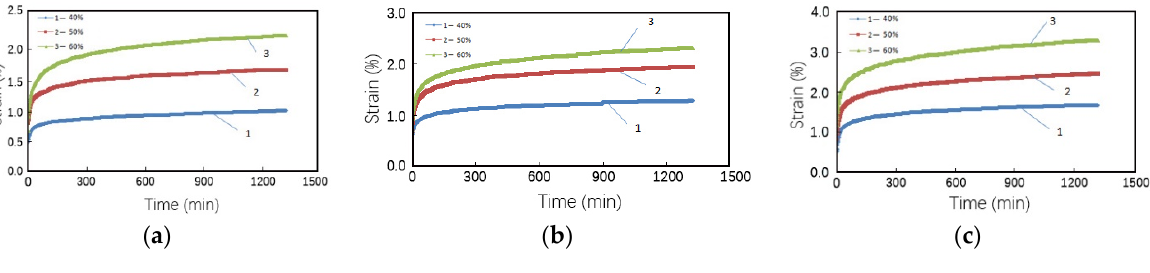
Figure 6. Creep strain trend for different temperatures: ( a ) 30 ◦ C; ( b ) 35 ◦ C; ( c ) 40 ◦